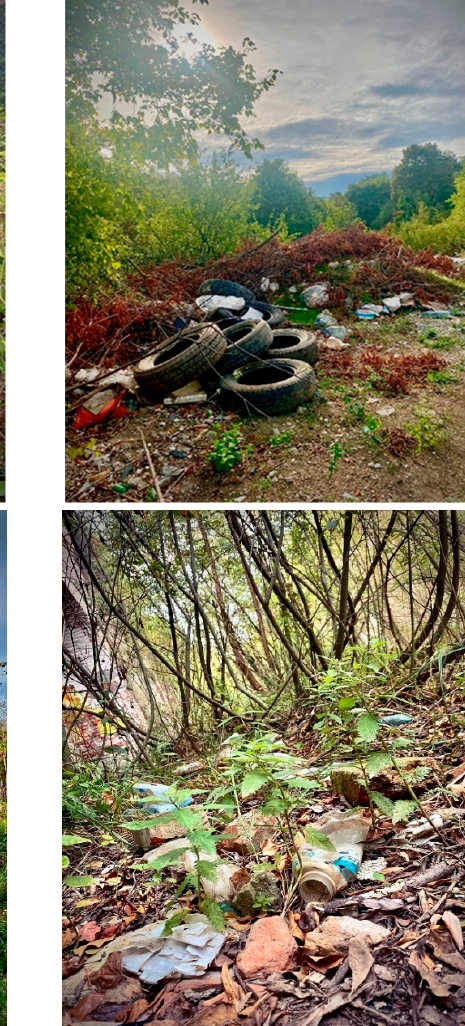
Figure 2. Sources of microplastic contamination (original photographs taken by the authors in iso- lated locations from Fortul I, Chitila 44°29’46” N 25°59’12” E in Romania on 17 September 2022).